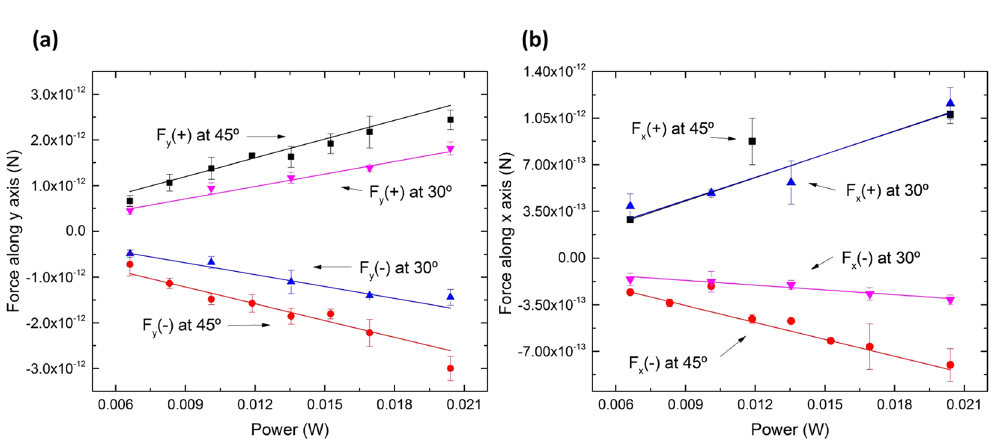
Figure 10. Optical forces acting on the particle, when it is at different locations: ( a ) at the trapping position F trans x and F axial x balance in the xy plan; ( b ) after the trapping point F trans x exceeds F axial x moving the particle towards the stable point; ( c ) before the trapping point, both F trans x and F axial x contribute positively to drive the particle to the stable position.